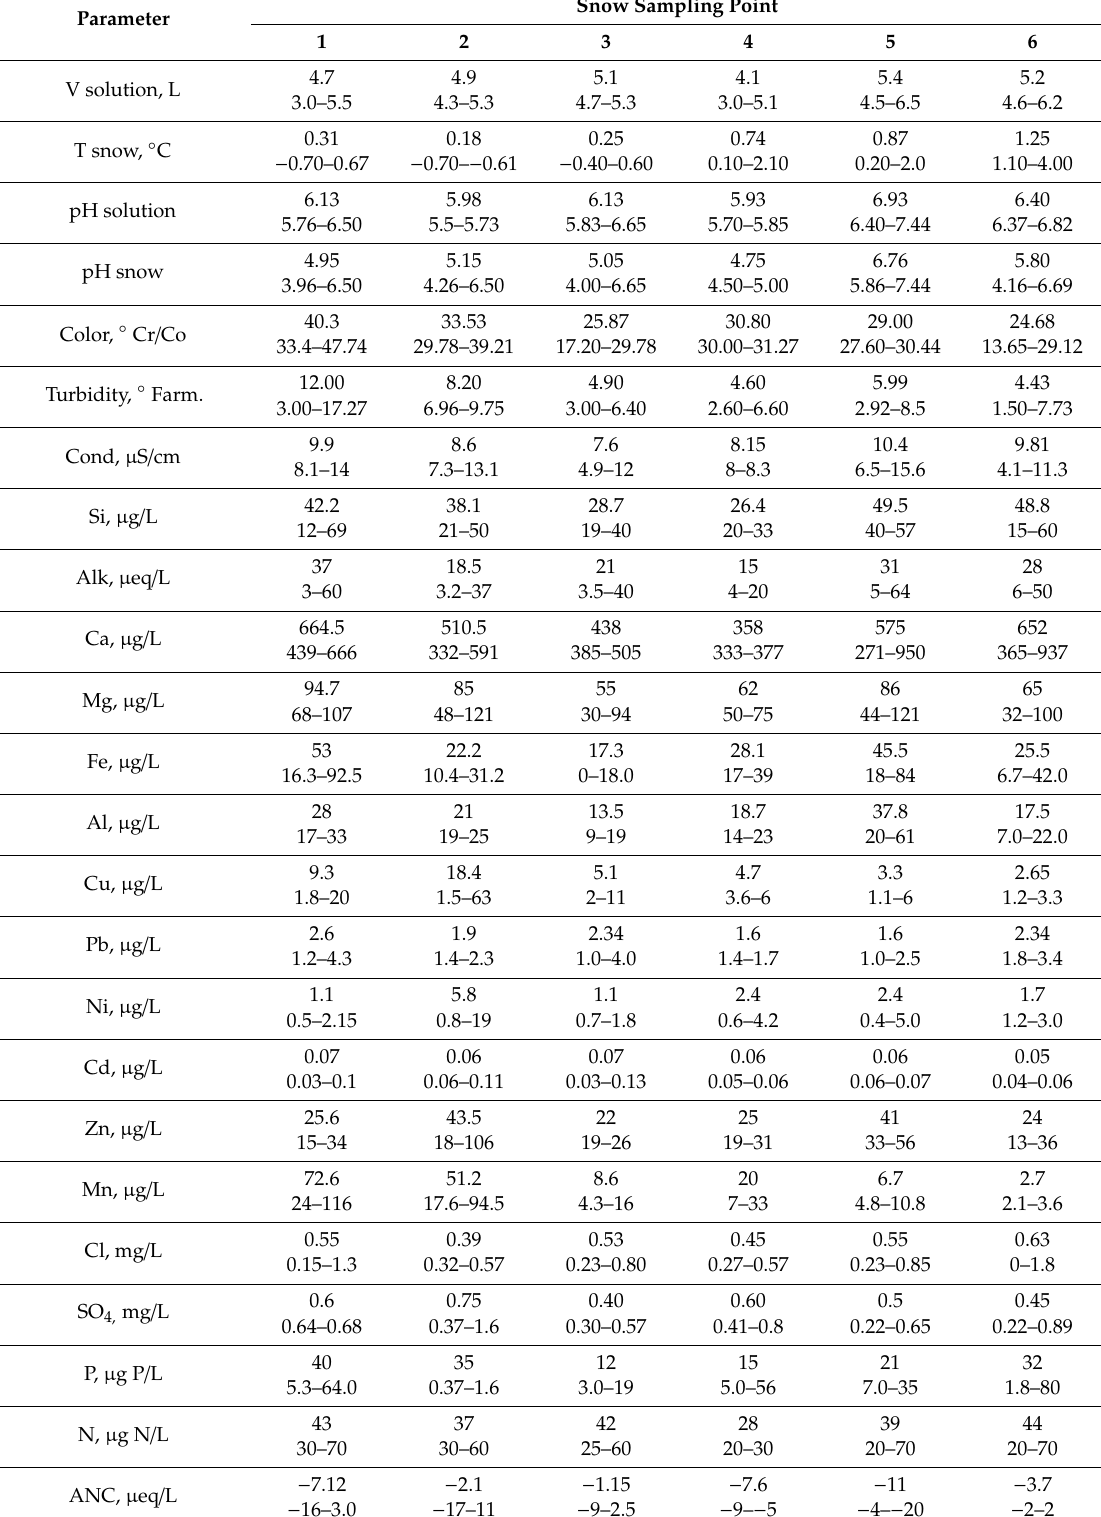
Table 1. Basic seasonal and physicochemical parameters of